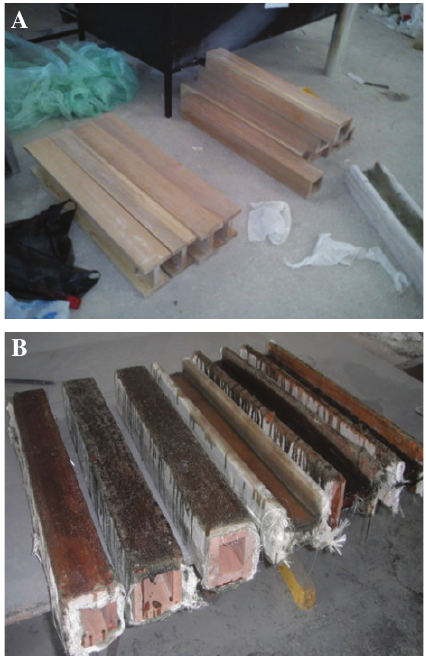
Figure 3 Photographs of (A) Group A and (B) Group B specimens. Figure 5 Photograph of Group B specimen under